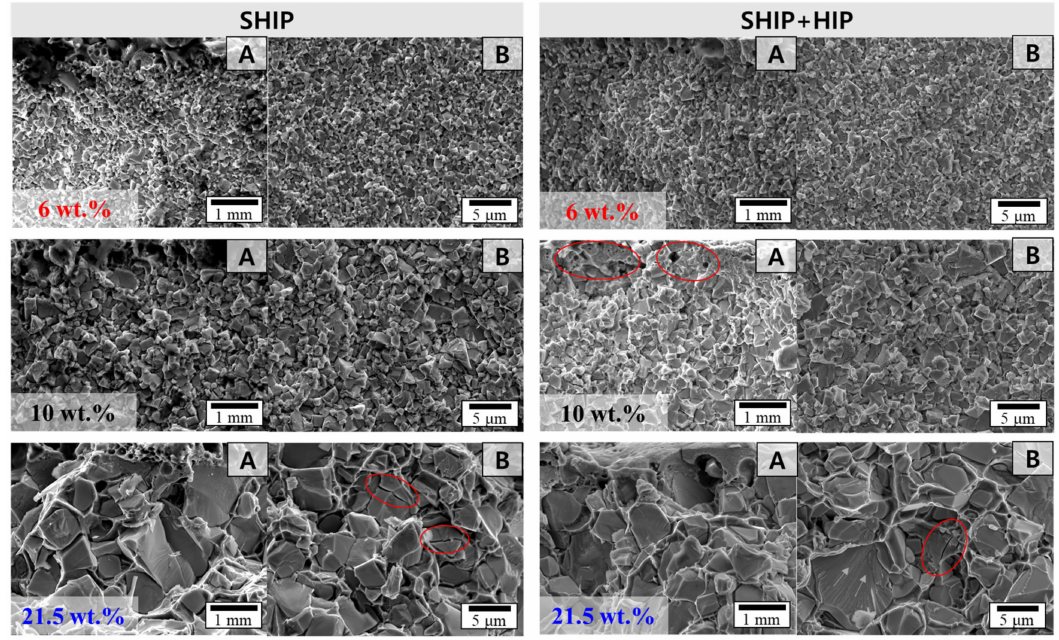
Figure 12. Comparison of SEM micrograph maps of impact